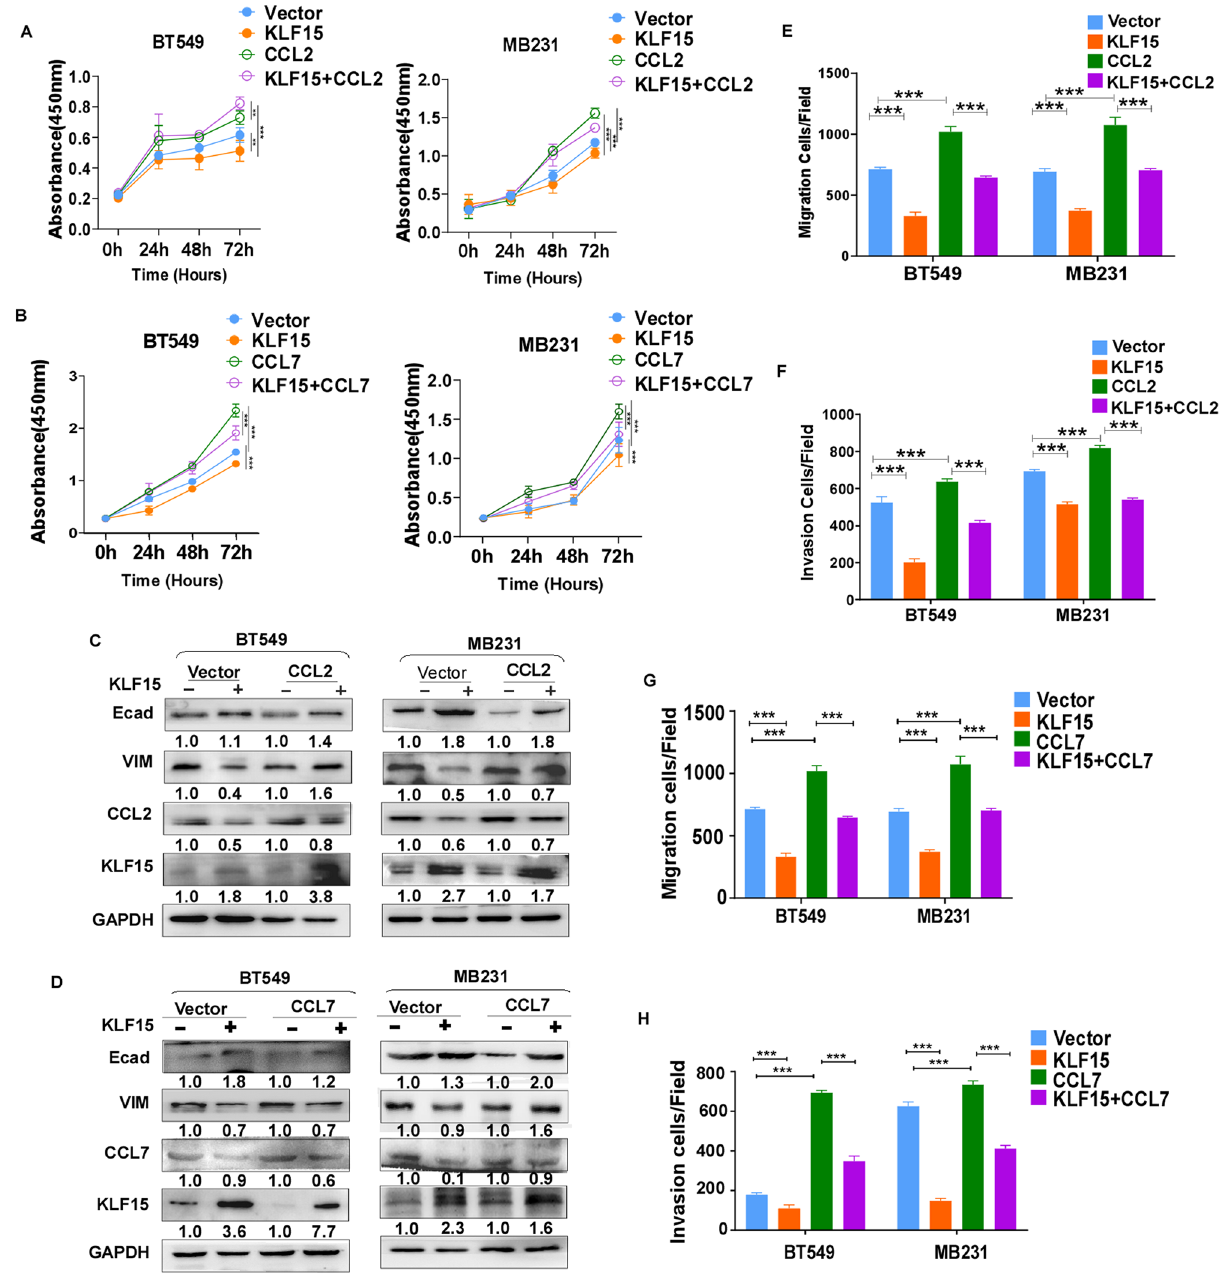
Figure 7. Exogenous CCL2 or CCL7 expression partially reverses KLF15’s effect on proliferation, migration and invasion. ( A , B ) Effect of acquired CCL2 or CCL7 overexpression on the proliferation of KLF15- overexpressing MDA-MB231 and BT549 cells. ( C , D ) Expression of CCL2 or CCL7 reverses EMT markers by KLF15. ( E , F ) Histograms showing migration and invasion results after CCL2 restoration in KLF15 expressing MDA-MB231 and BT549 cells. ( G , H ) Histograms showing migration and invasion results after CCL7 restoration in KLF15 expressing MDA-MB231 and BT549 cells. *** p <